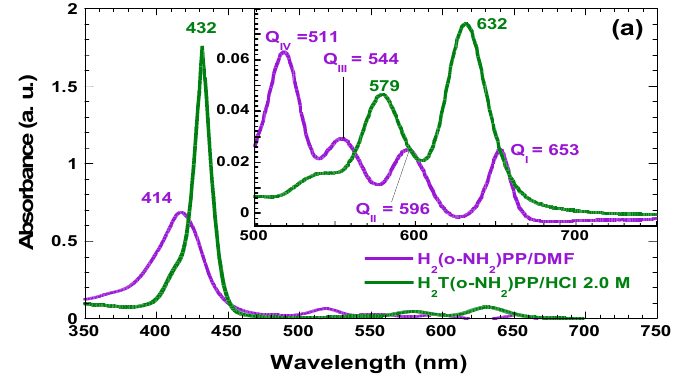
Figure 2. Absorption spectra in solution (organic or acidic media) of the ( a ) H T( p- COOH)PP species in ethanol. ( c ) Fluorescence spectra of the in methanol and ( b ) H 2 same species in organic solution and with λ = 370 nm. All spectra are taken at 25 ex